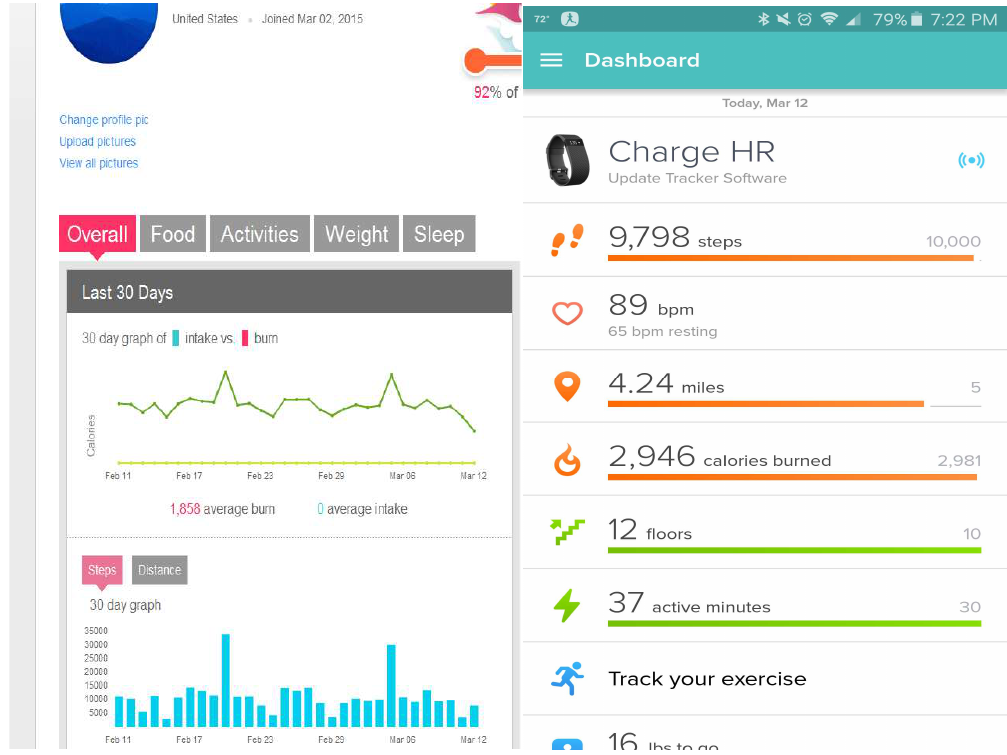
Figure 1. Fitbit screenshot of participant focusing on motivation metrics.